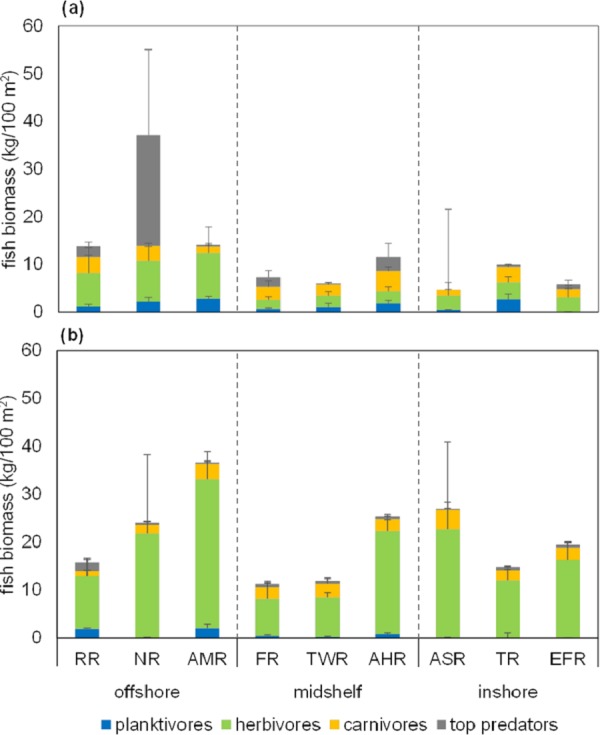
Stacked bar chart of mean biomass of four fish trophic groups.Mean fish biomass in kg/100 m2 for each of the nine study reefs at (A) 10 m, and (B) 2 m depth, color-coded according to stacked trophic group as per the inset key (planktivores, herbivores, carnivores, or top predators). Error bars show standard errors (SE) of the means. Means and SE bars shown are not relevant to the non-parametric tests described in the main text, but are shown to facilitate comparisons with other studies. Reef name abbreviations are presented on the x-axis (see main text for full names) and separated according to distance from shore into offshore, midshelf, and inshore reefs (delimited by vertical dotted lines for easy visualization). All data were collected in May 2013 from the central Saudi Arabian Red Sea.